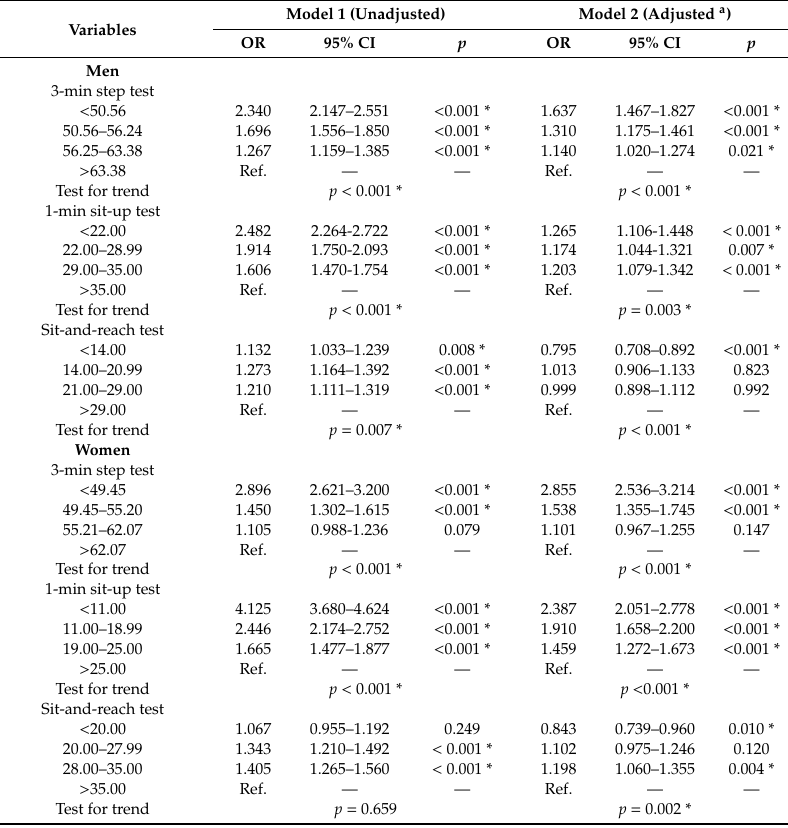
Table 5. Multivariate adjusted ORs for obesity in relation to quartiles of health-related physical fitness measurements after adjustment for potential